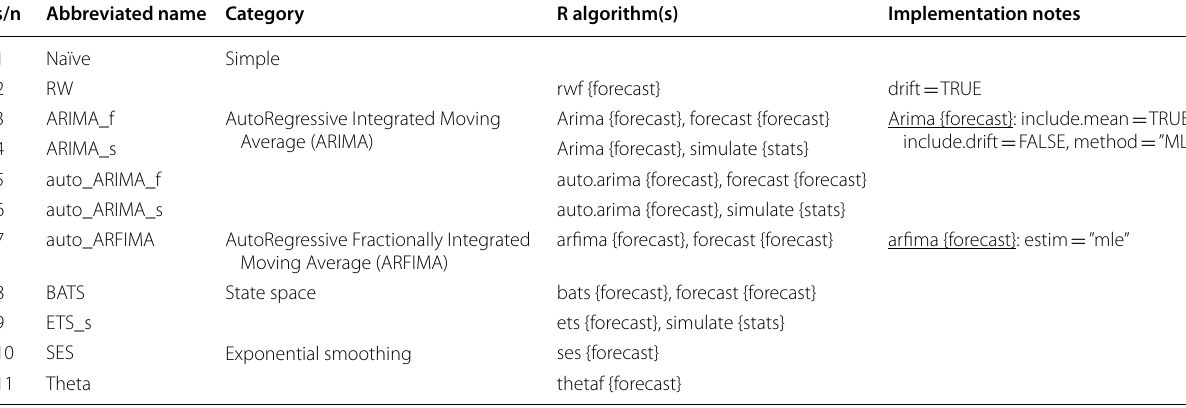
Table 4 Univariate time series forecasting methods of this study (part 1): stochastic methods s/n Abbreviated name